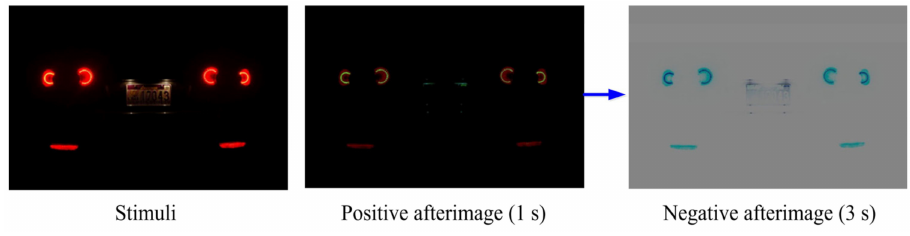
Figure 1. The transformation of